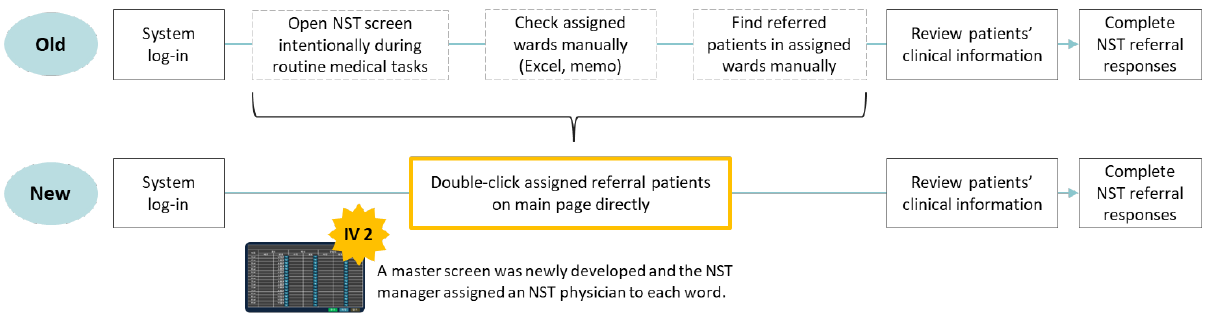
Figure 4. Simplified response steps by nutrition support team (NST) physicians at Seoul National University Bundang Hospital; IV2: Upgrade of NST attending physicians’ response steps.